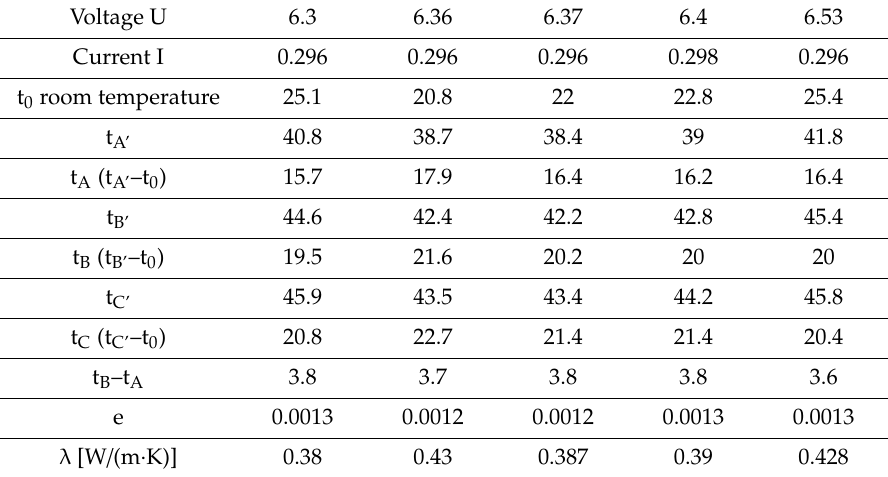
Table 5. Thermal conductivity coe ffi cient investigation